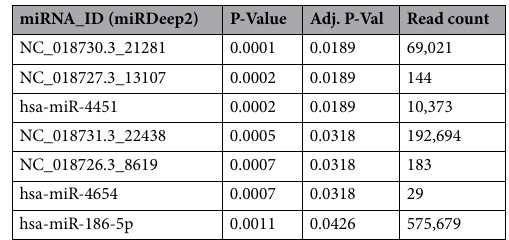
Table 2. List of the seven miRNAs with significant differential expression in affected and control cats also after the Benjamini–Hochberg correction (Adjusted P-value < 0.05).